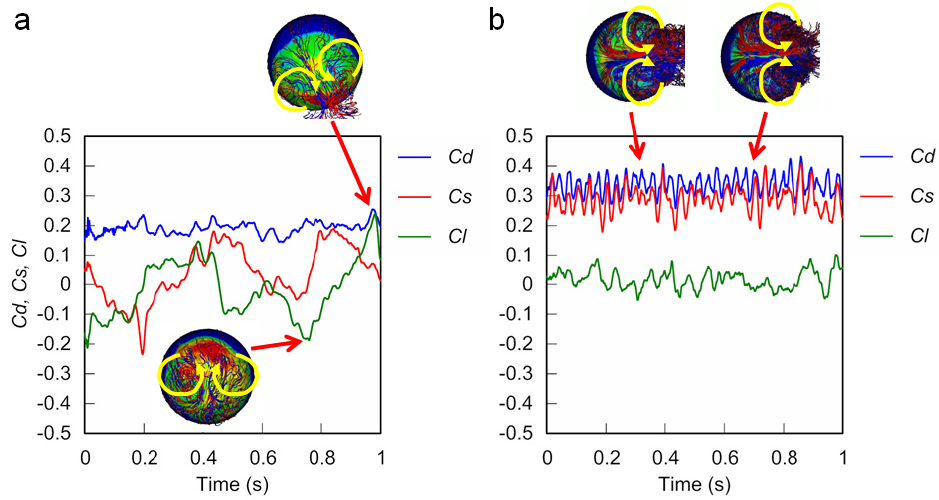
Figure 9. Drag, side, and lift force coe ffi cients of ( a ) nonspinning soccer ball for Re = 2.80 × 10 5 and ( b ) spinning soccer ball for Re = 4.25 × 10 5 (spin rate = 8 rps) obtained using CFD. The average unsteady Cs of the nonspinning ball was 0.054 (s.d. = 0.078) in the case of Nonspin A, 0.039 (s.d. = 0.090) in the case of Nonspin B, and 0.034 (s.d. = 0.050) in the case of Nonspin C (Figure